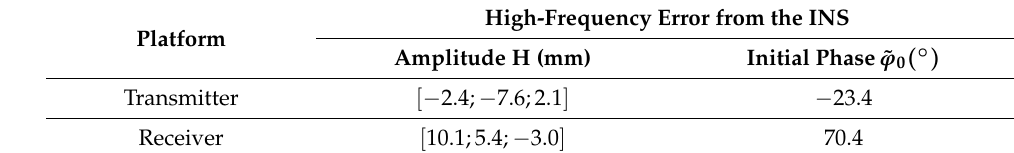
Table 7. High-frequency error parameters of the platforms obtained from the INS.